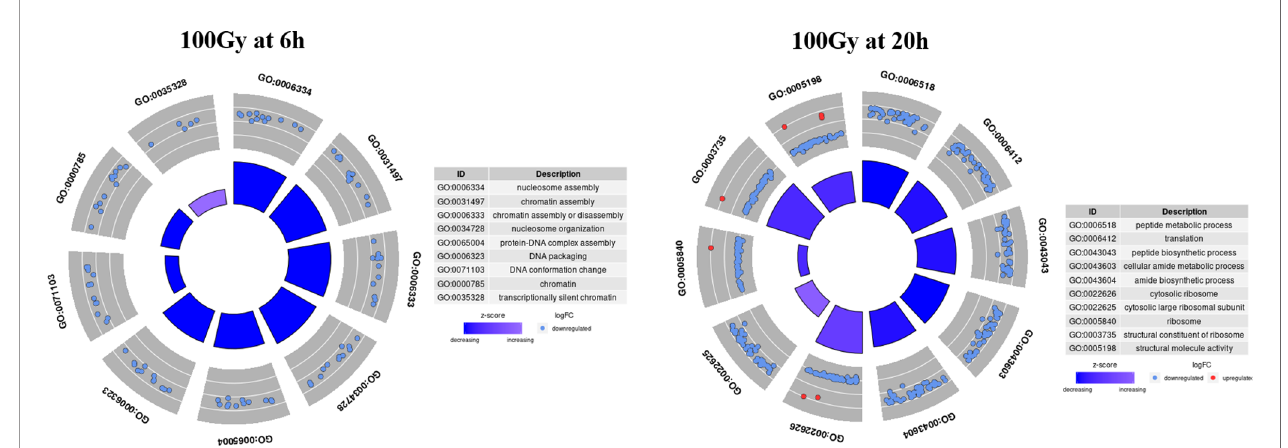
FIGURE 8 | Top 10 most signi fi cant GO terms for 100Gy at 6h and 20h post-irradiation. GO circle plots for the top 10 most signi fi cant GO enrichment terms with fold-changes of individual genes taken in account and calculated as Z score at 20h post-irradiation. The height of the inner bar chat designates the signi fi cance of the GO term plotted. Most processes at both periods post-irradiation were down regulated.